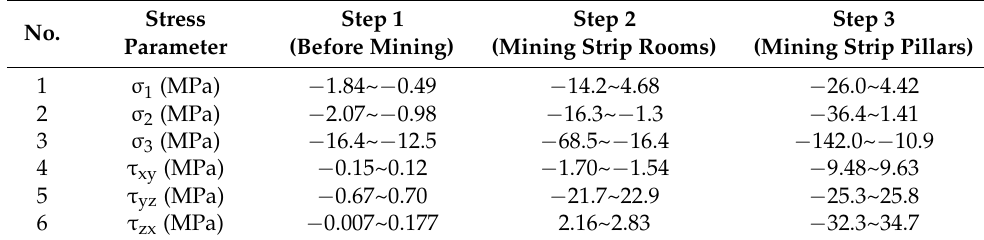
Table 2. Numerical simulation results of the recovery process before